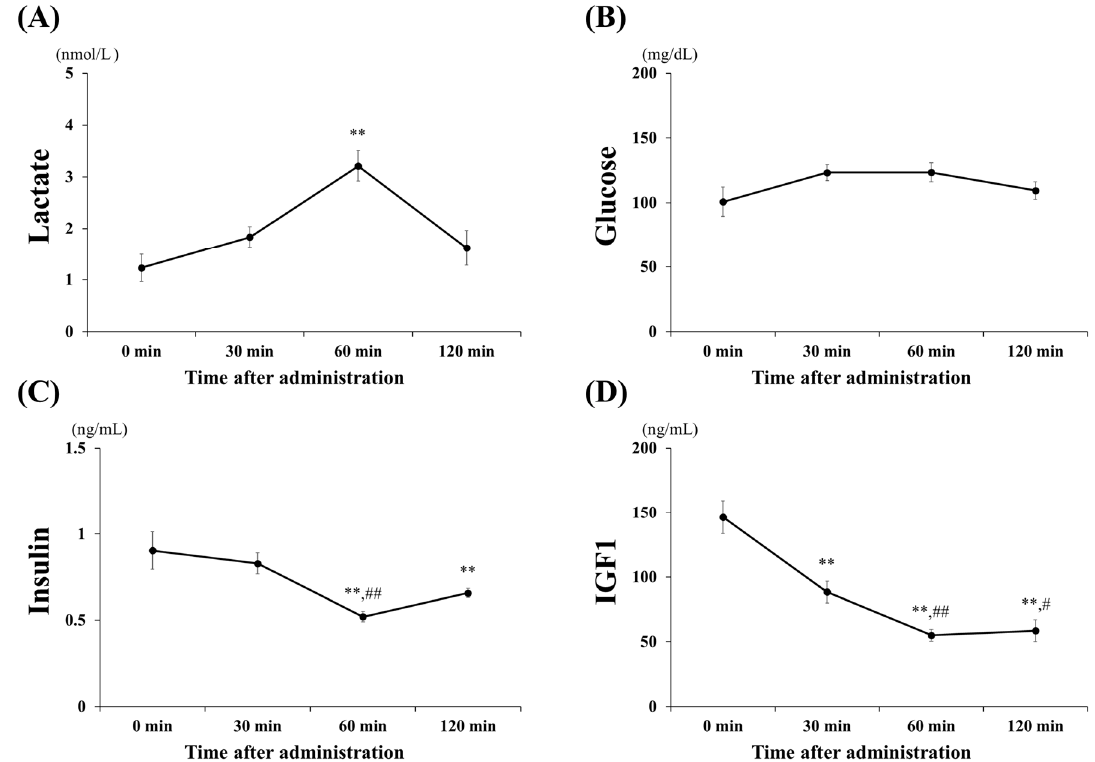
Figure 2. Blood (plasma) parameters. Changes in blood (plasma) ( A ) lactate, ( B ) glucose, ( C ) insulin-like growth factor 1 (IGF1), and ( D ) insulin concentrations after lactate administration (2 g / kg) within 120 min. The values shown represent the means ± SDs ( n = 8). ** p < 0.01, vs. the 0 min (control group). # p < 0.05, ## p < 0.01, vs. the 30 min after lactate administration.